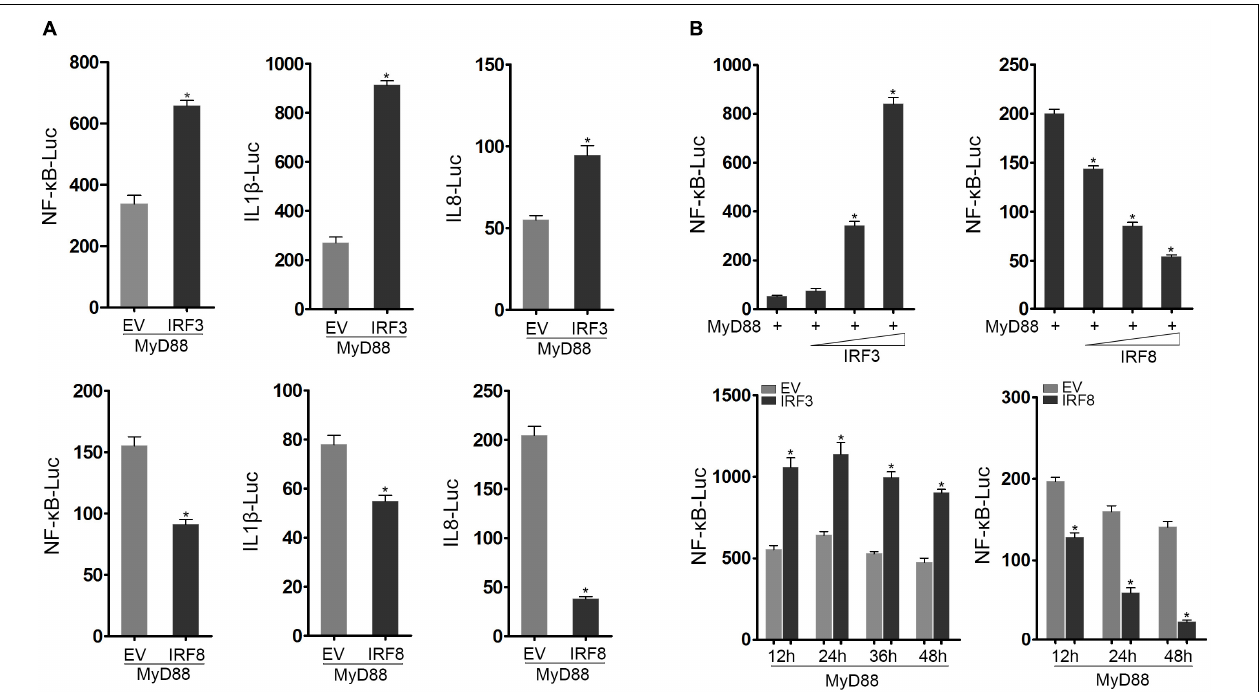
FIGURE 2 | IRF3 and IRF8 regulate MyD88-mediated NF- κ B signaling pathway. (A) Epithelioma papulosum cyprini (EPC) cells were seeded in 24-well plates and cotransfected with 0.2 µ g of MyD88 and 0.2 µ g of pcDNA3.1, IRF3 or IRF8, respectively, together with 0.25 µ g of NF- κ B, IL-1 β reporter gene or IL-8 reporter gene, respectively. After 24 h post transfection, the luciferase activity was measured. (B) The concentration gradient experiment of IRF3 (0.05, 0.1, or 0.2 µ g) or IRF8 (0.05, 0.1, or 0.2 µ g) expression plasmid within 0.2 µ g of MyD88 and 0.25 µ g of NF- κ B reporter gene was conducted. After 24 h post transfection, the luciferase activity was measured. After being cotransfected with MyD88 and IRF3 or IRF8 expression plasmids, together with NF- κ B reporter gene, the luciferase activity was measured at different time points. The “EV” represents pcDNA3.1 empty plasmid. The luciferase activity value was achieved against the Renilla luciferase activity. * p < 0.05 versus the controls. All experiments were performed in at least three independent experiments.